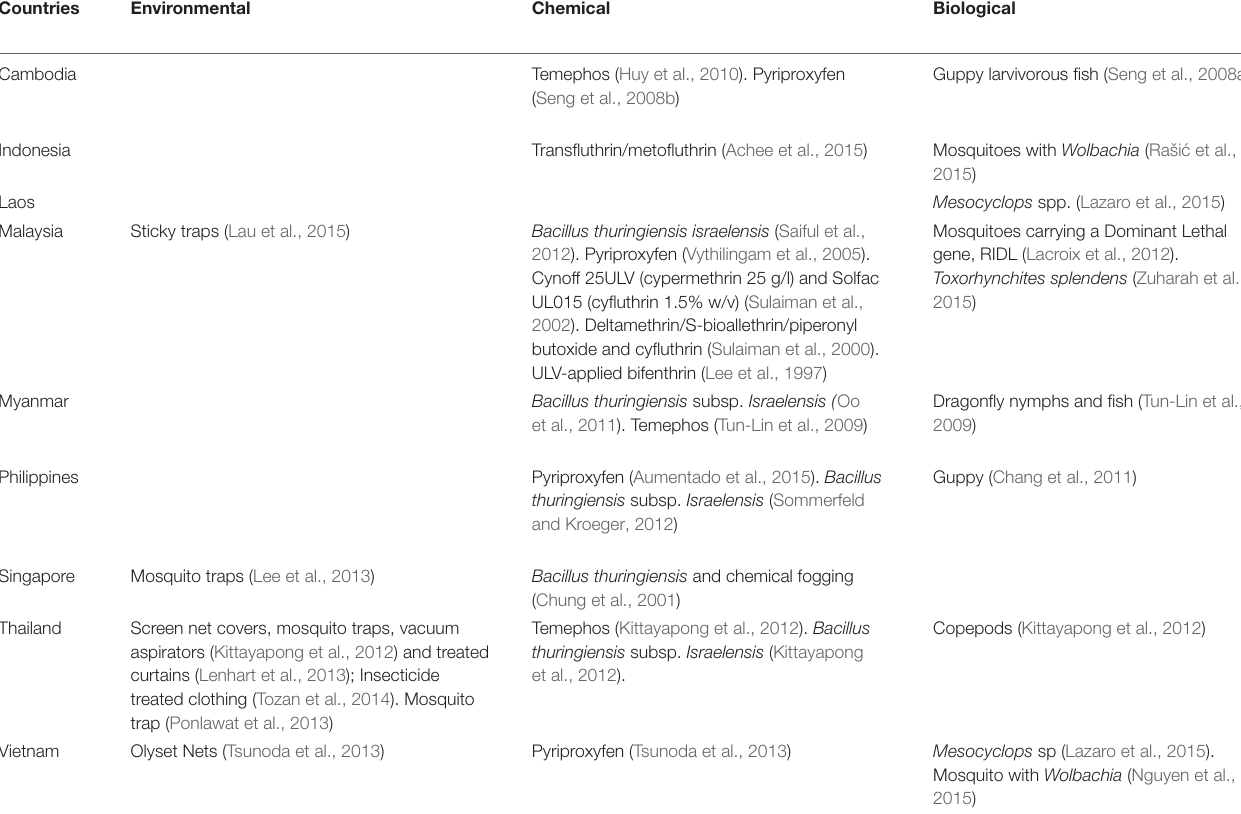
TABLE 1 | Current research on Aedes vector control in Southeast Asian over the past 25 years.